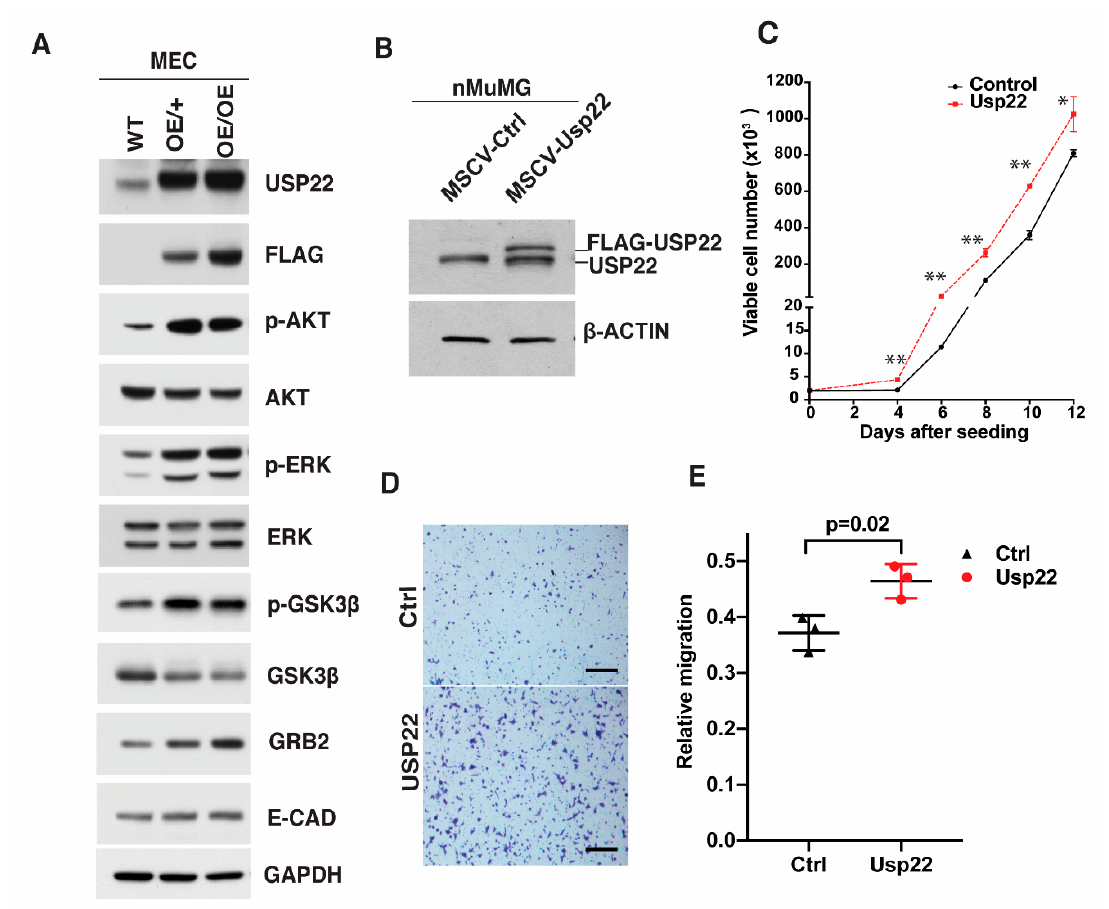
Figure 4. Deregulation of signaling cascades in primary epithelial cells and mammary cell lines upon Usp22 overexpression. ( A ) Representative immunoblots showing increased levels of phosphorylated forms of ERK1/2, AKT, and GSK3 β , as well as increased protein levels of GRB2, but not E-cadherin, in MECs overexpressing Usp22 . ( B ) Immunoblot showing the stable overexpression of FLAG-tagged Usp22 in immortalized NMuMG cells. ( C ) Growth assays indicate that Usp22 - overexpressing NMuMG mouse epithelial cells show a limited increase in their proliferative capacity compared to the control cell line. ** p < 0.01, * p < 0.05. ( D ) Representative bright-field images of transwell migration assays using control or Usp22 overexpressing NMuMG mouse epithelial cells, stained with crystal violet. Scale bar—400 µ m. ( E ) Quantification of migrating Usp22 overexpressing and control NMuMG mouse epithelial cells, measurements performed with crystal violet absorbance value of migrated cells from three replicates per group. Error bars represent SD of three replicates per group. p values were calculated using unpaired t tests.